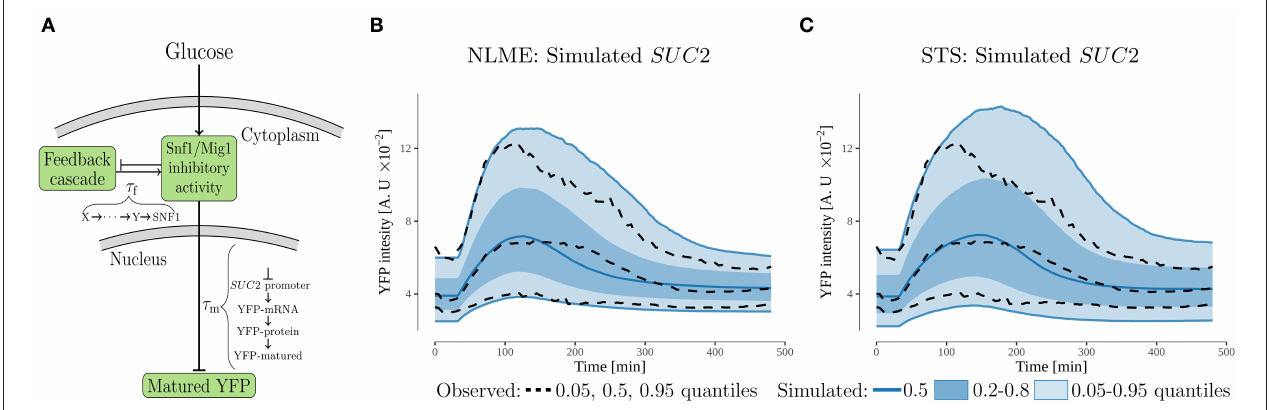
FIGURE 3 | The feedback cascade model. (A) Schematic representation. The model proposes that the SUC2 expression decreases during glucose starvation due to a feedback acting on the inhibitory activity of the Snf1/Mig1 pathway. A potential source of this feedback is partial recovery in the intracellular energy levels. The feedback-cascade, and maturation time of the promoter SUC 2 -YFP (measured output), were represented by time-delays, τ i . (B,C) Simulated and observed population behavior of the SUC2-intensity (note same scale on y-axis). The simulated data was generated by simulating 10,000 cells using the estimated parameter distributions for the NLME and STS